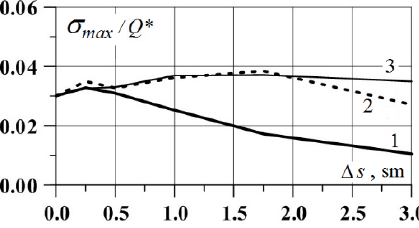
Fig. 4. Dimensionless values of the maximum tensile radial stresses at the point at a distance of 20 r from the wall of an explosive well depending on the magnitude of the gap ∆ s and filled it with an inert material: 1 - air gap 2 - the gap filled with sand, 3 - gap filled with water